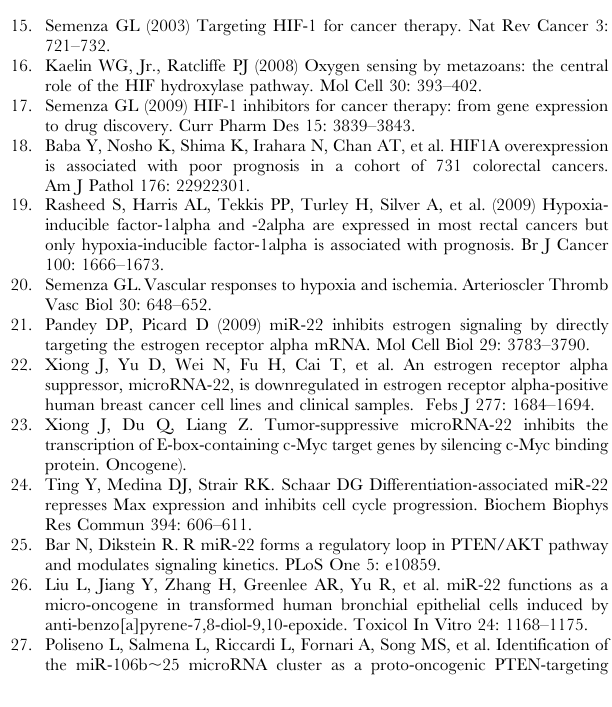
Figure S1 HIF-1 b is not a target of miR-22. Description: HCT116 cells were transfected with pre-miR-22 or pre-miR- control, and exposed to normoxia or hypoxia for 16 h. Cell lysates were immunoblotted for HIF-1a and HIF-1b. Over-expression of miR-22 inhibits HIF-1a expression, but not HIF-1b. (TIF) Figure S2 MiR-22 regulates the expressions of angio- genic factors. Description: HCT116 cells were transfected with pre-miR-22 or control, and then exposed to normoxia or hypoxia for 8 h. RNAs from cell lysates were analyzed for angiopoietin 2 (ANGPT-2), stem cell factor (SCF), and COX-2 mRNAs by qPCR (n= 3 6 S.D. *P , 0.05) Over-expression of miR-22 decreased the expressions of angiogenic factors.